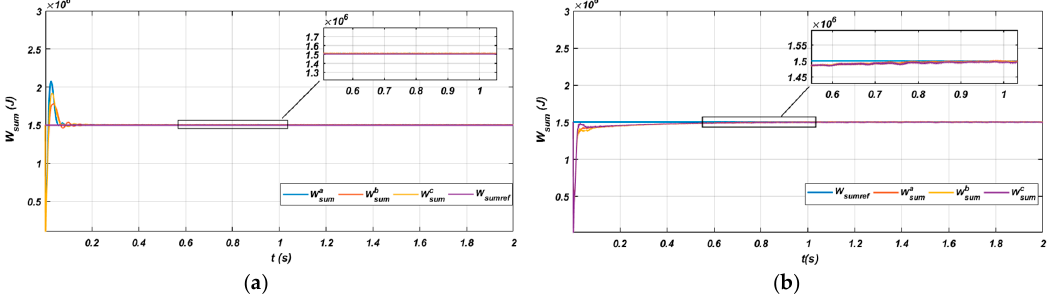
Figure 14. ( a ) Sum energy of arms using the API controller; ( b ) sum energy of arms using the PR controller. Energies 2019 , 12 , x FOR PEER REVIEW